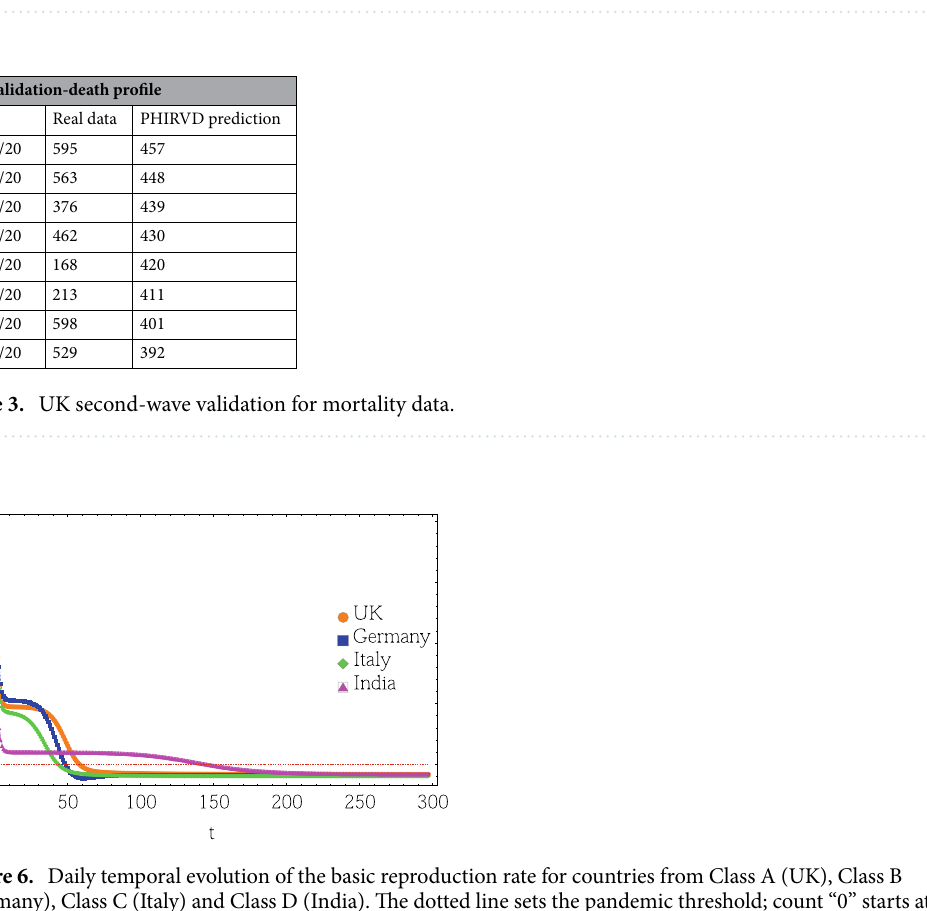
Table 2. Validation of daily new infected and death: UK (Class A), Germany (Class B), Italy (Class C), India (Class D).